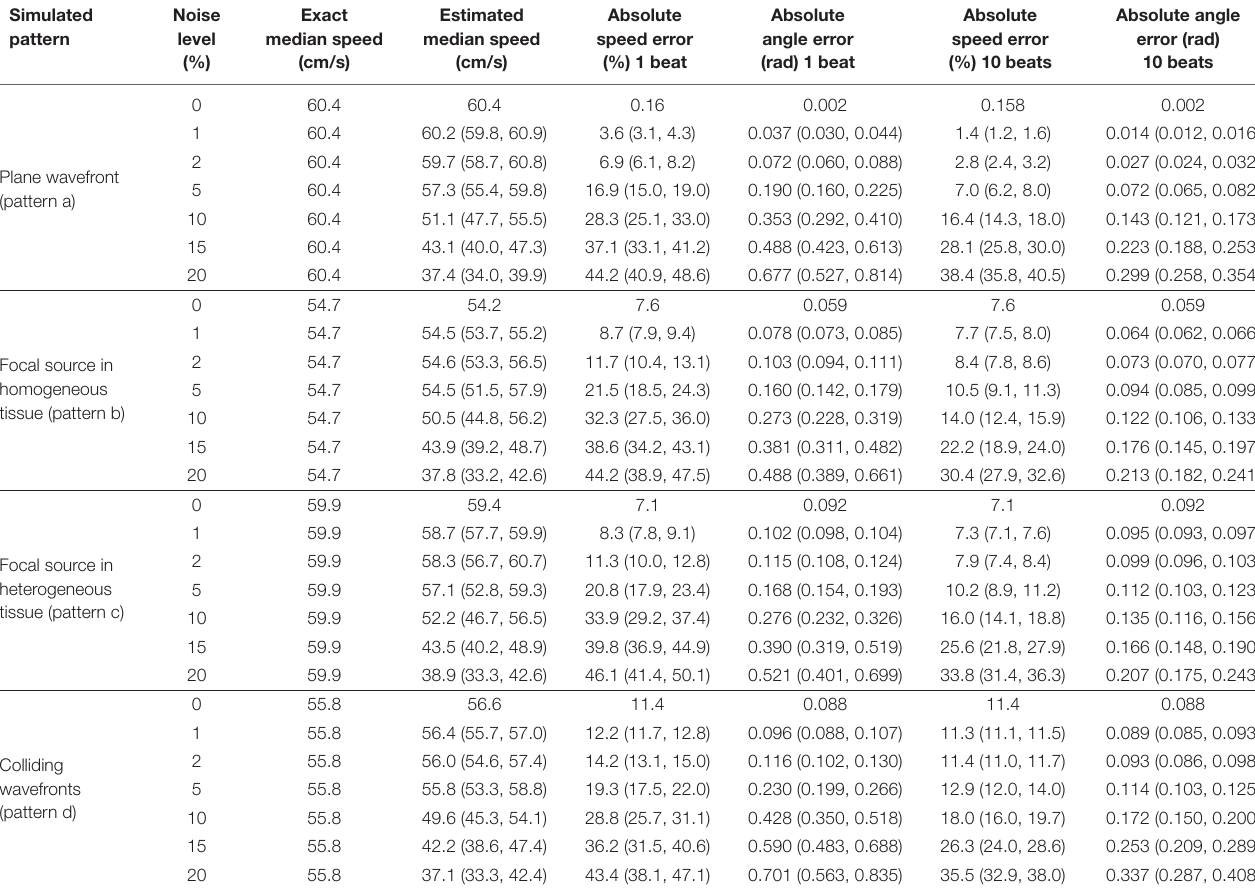
TABLE 2 | Effects of temporal noise (expressed as percentage of atrial cycle length) on the estimation of median velocity, velocity vector magnitudes, and directions. Simulated